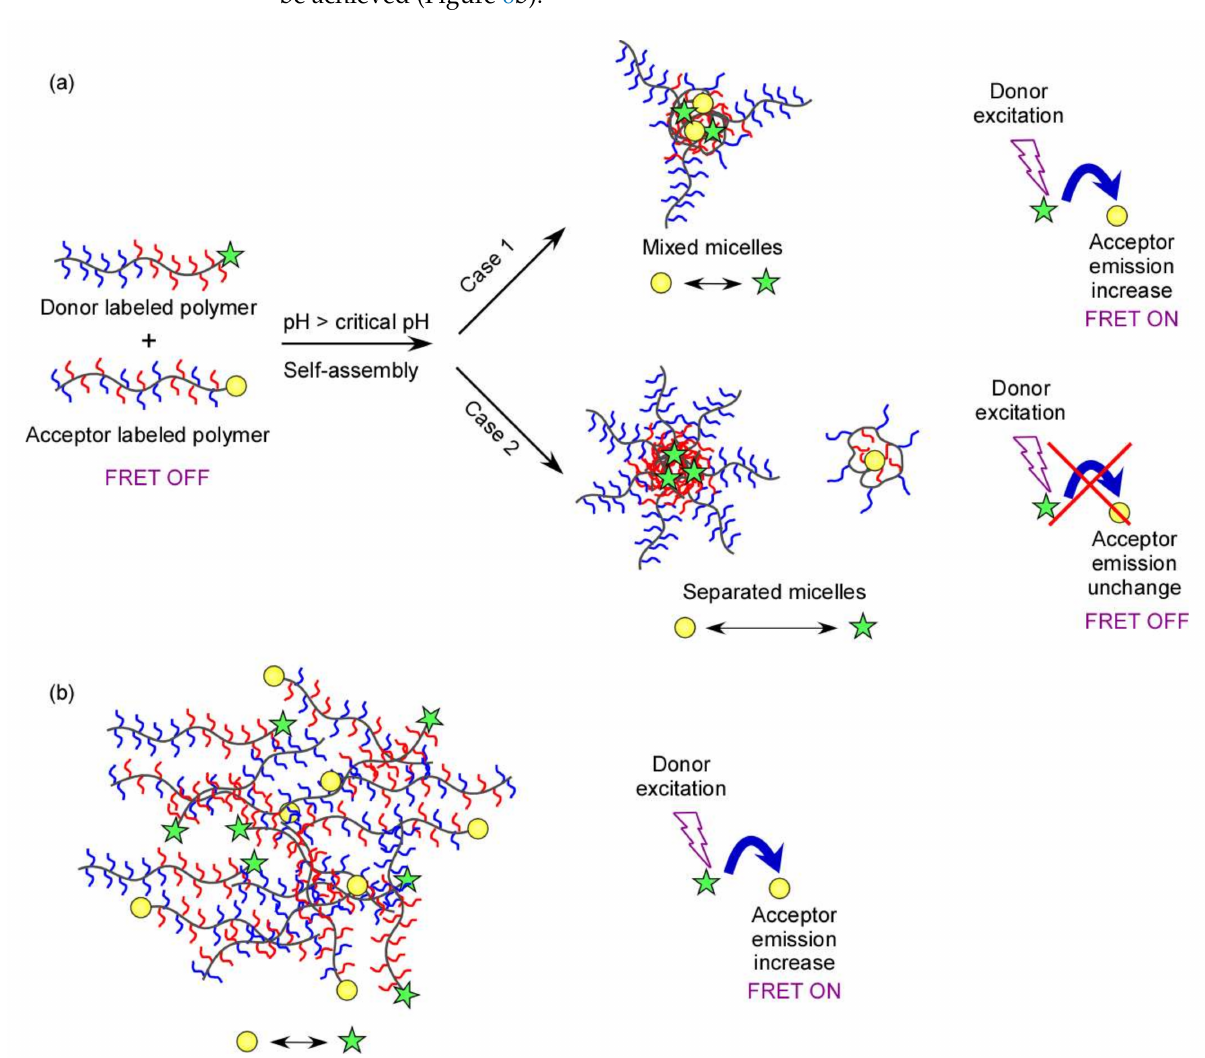
Figure 6. Schematic of a fluorescence resonance energy transfer (FRET) experiment in a mixture of random and block copolymers at low concentration and high concentration of donor and acceptor in ( a ) water and ( b ) a poor solvent,